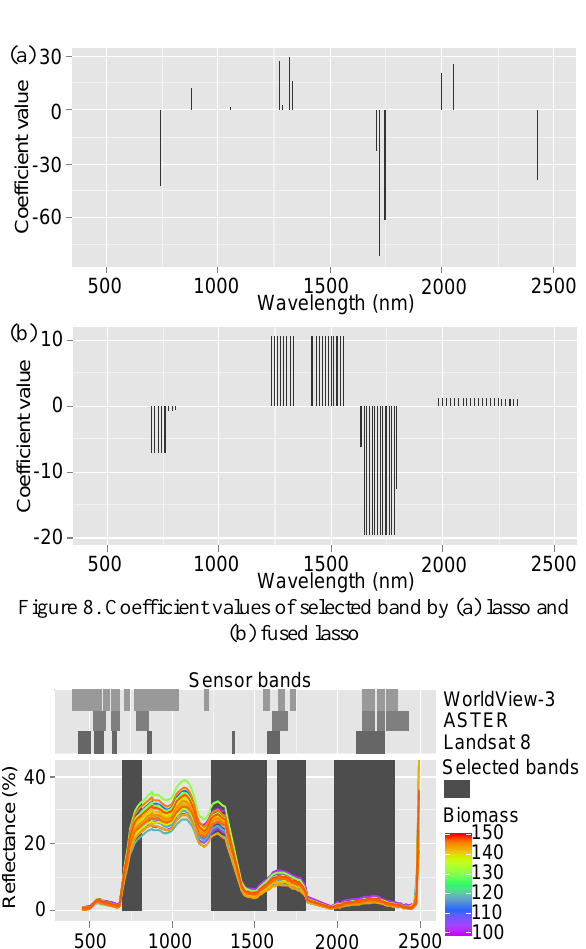
Figure 10. Spectral curves acquired from all the field survey plots with spectral ranges of selected bands by fused lasso and spectral bands of existing multispectral sensors